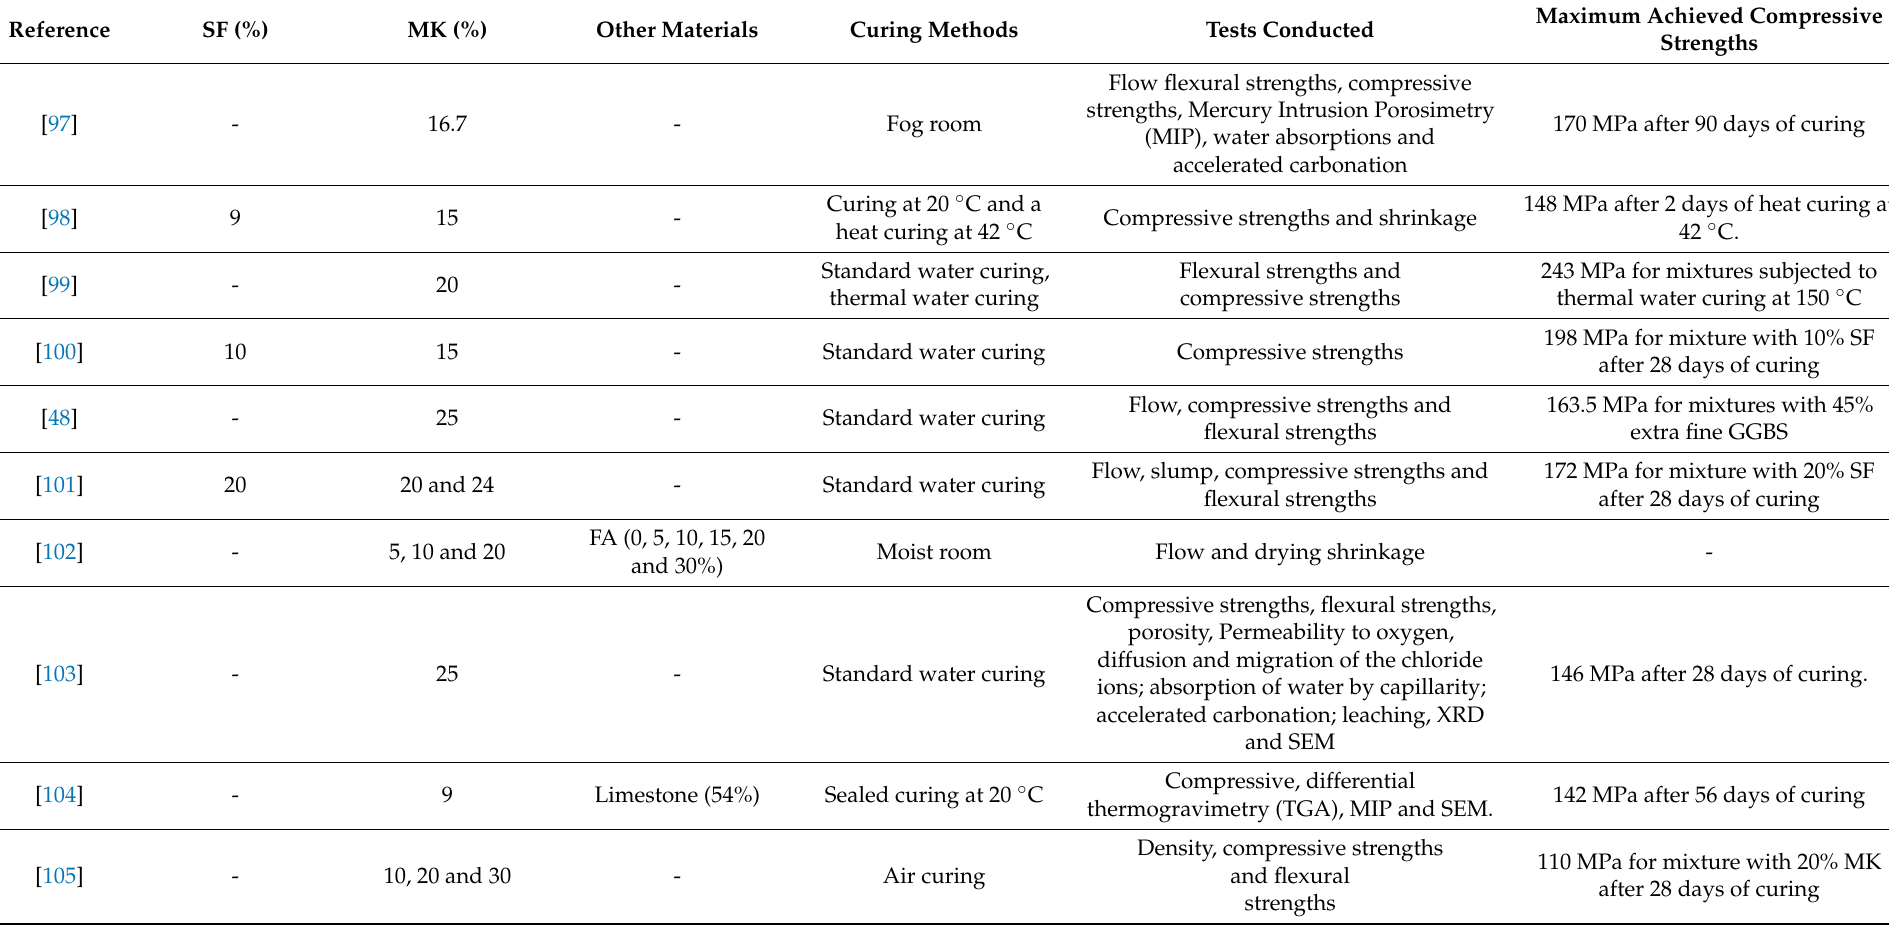
Table 3. Investigates on the utilization of MK in the production of